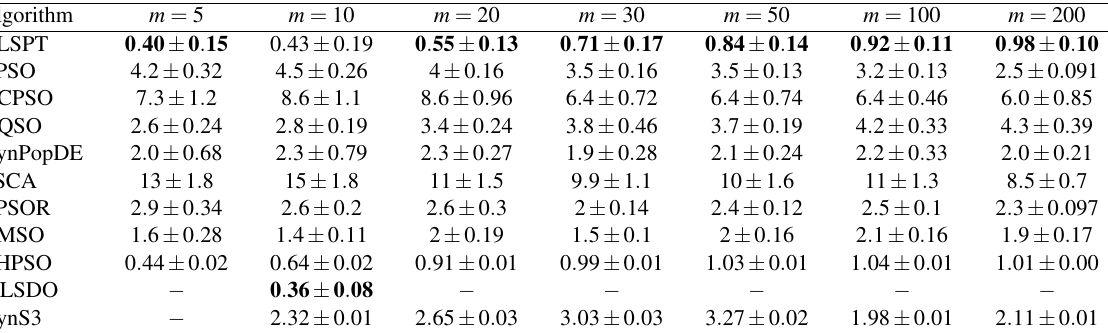
Table 9. e of f and standard deviation obtained by our proposal (ALSPT) and the considered state-of- the-art algorithm in the MPB with different number of peaks ( m = { 5 , 10 , 20 , 30 , 50 , 100 , 200 } ) Algorithm